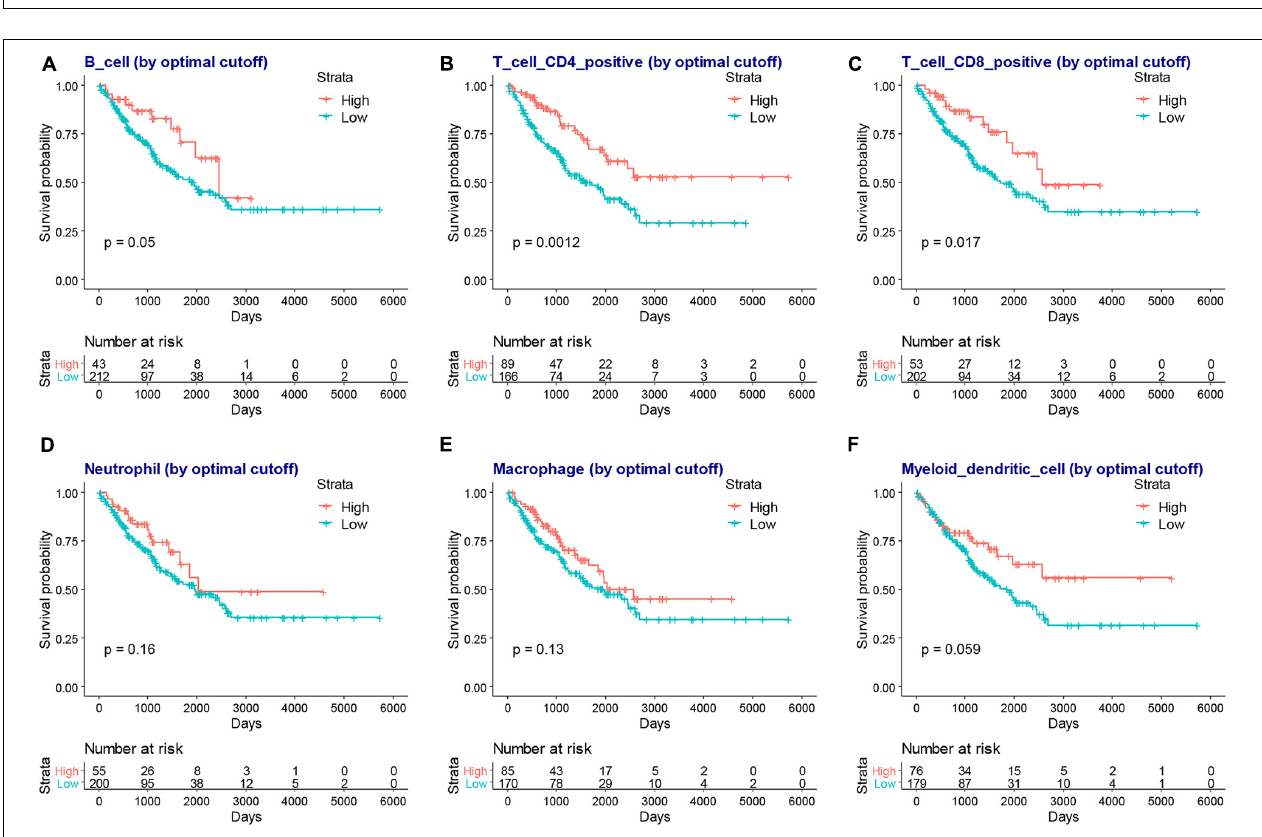
FIGURE 4 | The association between infiltration level of immune cells and the immune scores/stromal scores in patients with SARC. The infiltration levels of B cells, CD4+ T cells, CD8+ T cells, neutrophils, macrophages, and myeloid dendritic cell in patients with SARC according to (A) immune scores and (B) stromal scores.